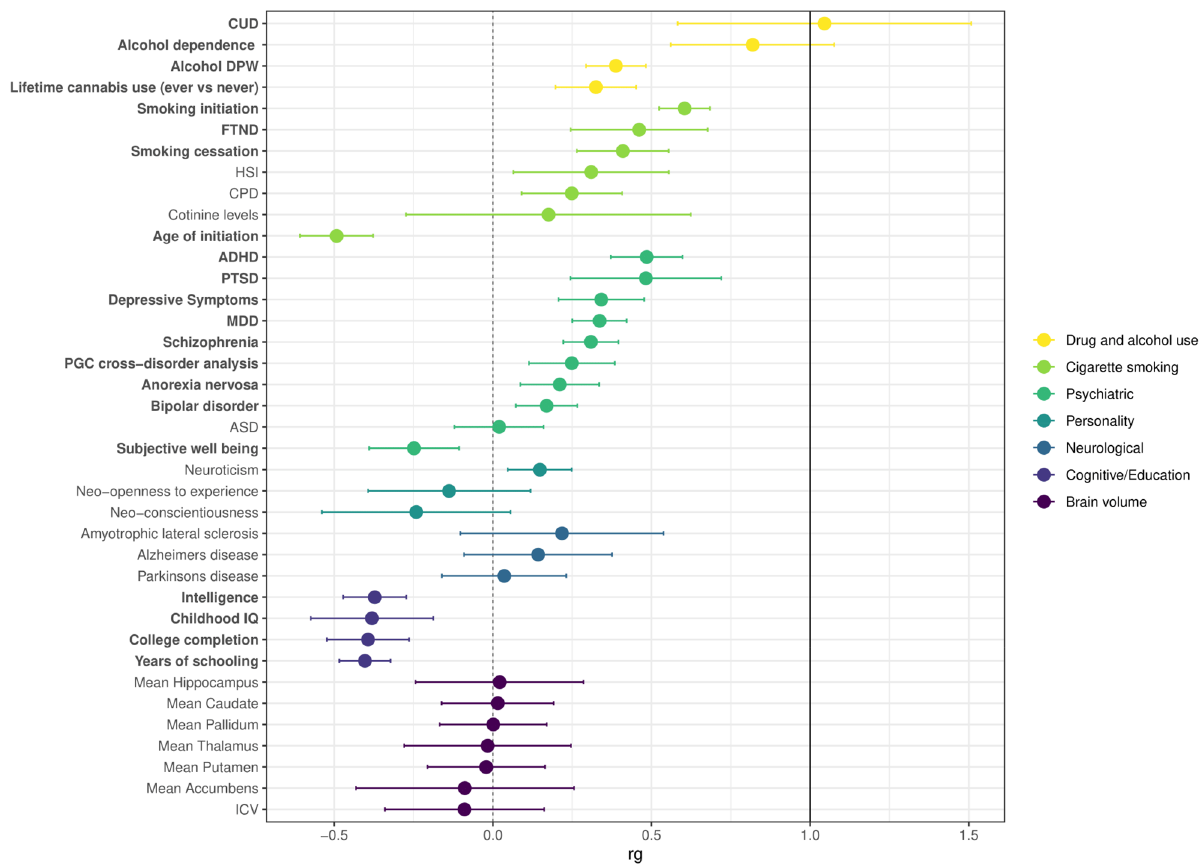
Figure 3. Genetic correlations of opioid addiction (OA) with 38 other brain-related phenotypes. Correlations were calculated using linkage disequilibrium (LD) score regression with the gSEM OA GWAS meta-analysis results, compared with results made available via LD Hub or study investigators (see Supplementary Table 24 for original references). Phenotypes were grouped by disease/trait or measurement category, as indicated by different colorings. Dots indicate the mean values for genetic correlation ( r g ); error bars show the 95% confidence intervals; the dashed vertical black line corresponds to r g = 0 (no correlation with OA), and the solid vertical black line corresponds to r g = 1.0 (complete correlation with OA). Phenotypes with significant correlation with OA are bolded (1 degree of freedom Chi-square test; Bonferroni adjusted p -value < 0.05